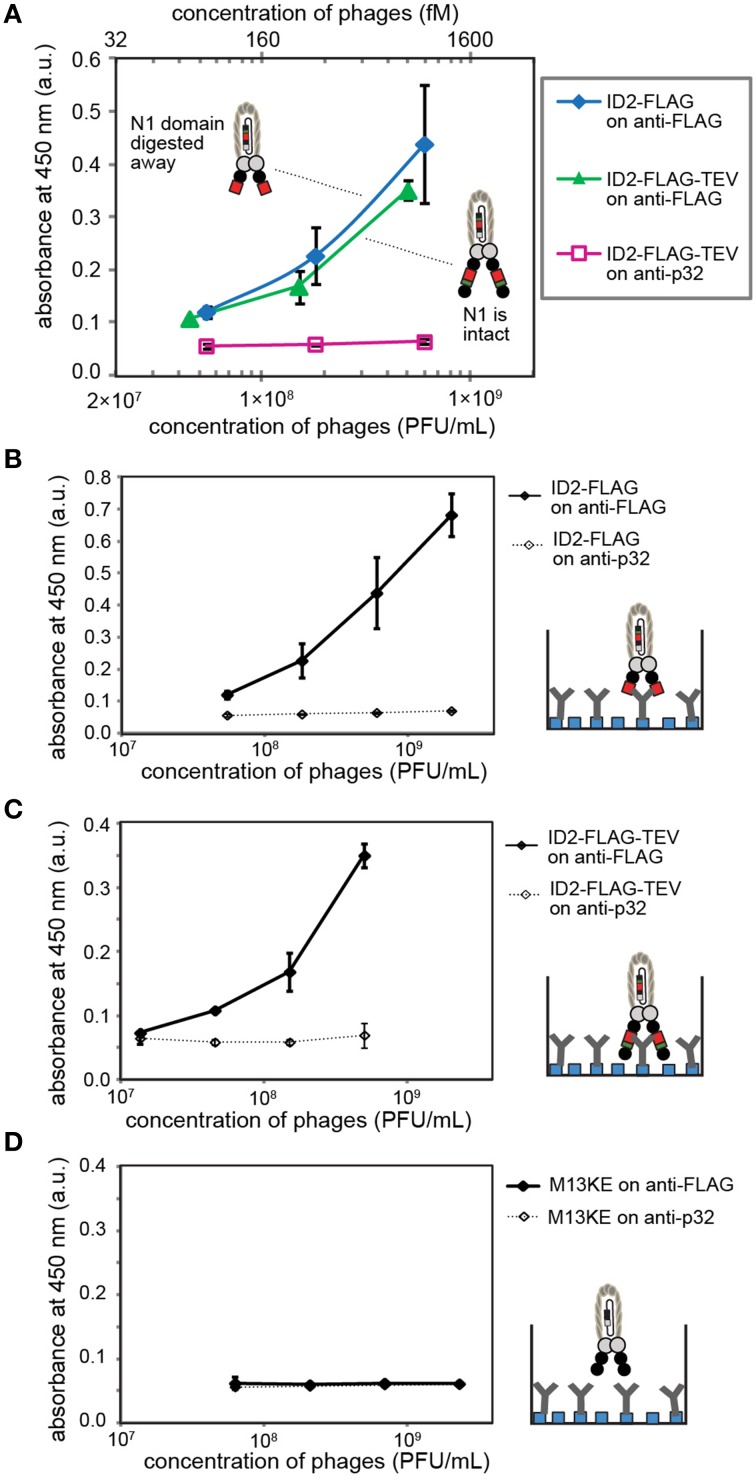
(A) ELISA detects inserted FLAG sequences before and after digestion of ID2-FLAG-TEVrs phage by TEV protease. When tested side-by-side, digested and non-digested phage exhibit similar binding response. This observation suggests that the N2 domain does not interfere with binding of anti-FLAG antibody. (B–D) Control experiments in which we compared (B) binding of digested phage to matched (anti-FLAG) and mismatched (anti-p32) antibody; (C) binding of undigested phage to matched/mismatched antibody; (D) binding of insert-free phage to matched/mismatched antibody. Antibodies were immobilized on protein-A coated wells. Data represents average from three independent wells; error bar is one standard deviation.